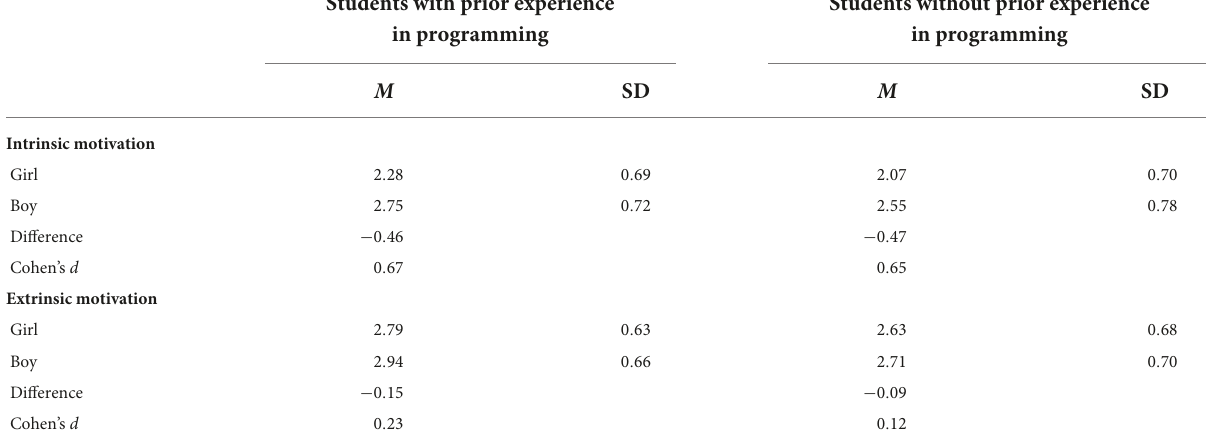
TABLE 9 Mean and standard deviations, mean differences, and effect sizes (Cohen’s d ) of intrinsic and extrinsic motivation among the student respondents by gender and separately for with and without programming experience. Students with prior experience Students without prior experience in programming in